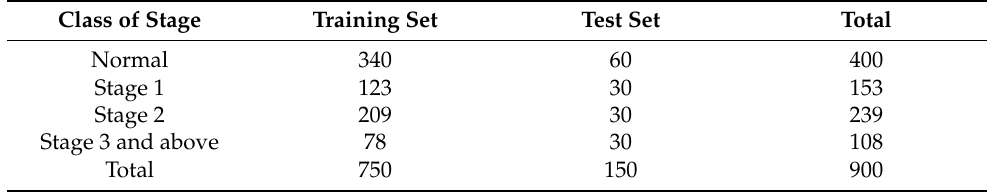
Table 2. Dataset used for training and testing the proposed method in this